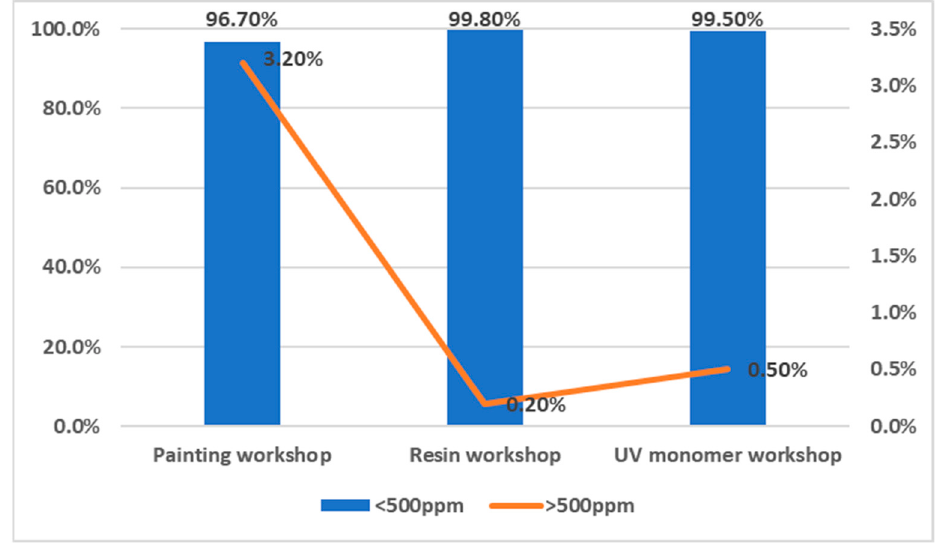
Figure 2. Leakage of production unit components.